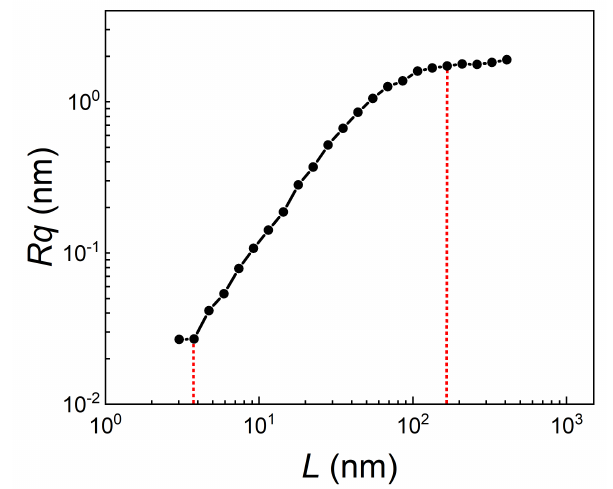
Figure 5. The R q - L curve of RSE method with f1. The linear part in double logarithmic coordinates between the red dotted line was the scaling region.